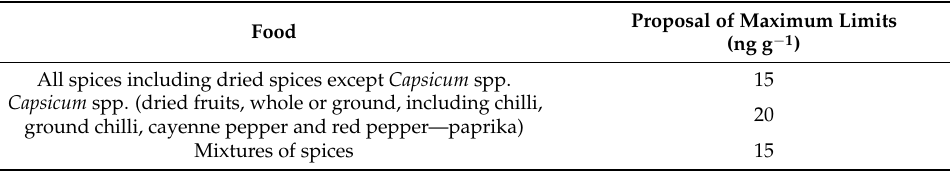
Table 5. The draft proposal of the maximum limits of OTA in spices.